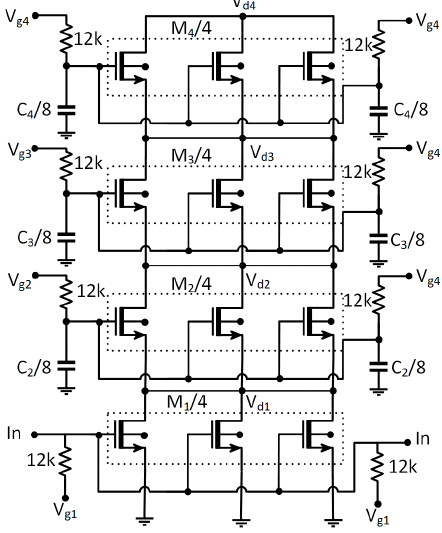
Figure 3. Schematic of one power cell of the stacked PA.